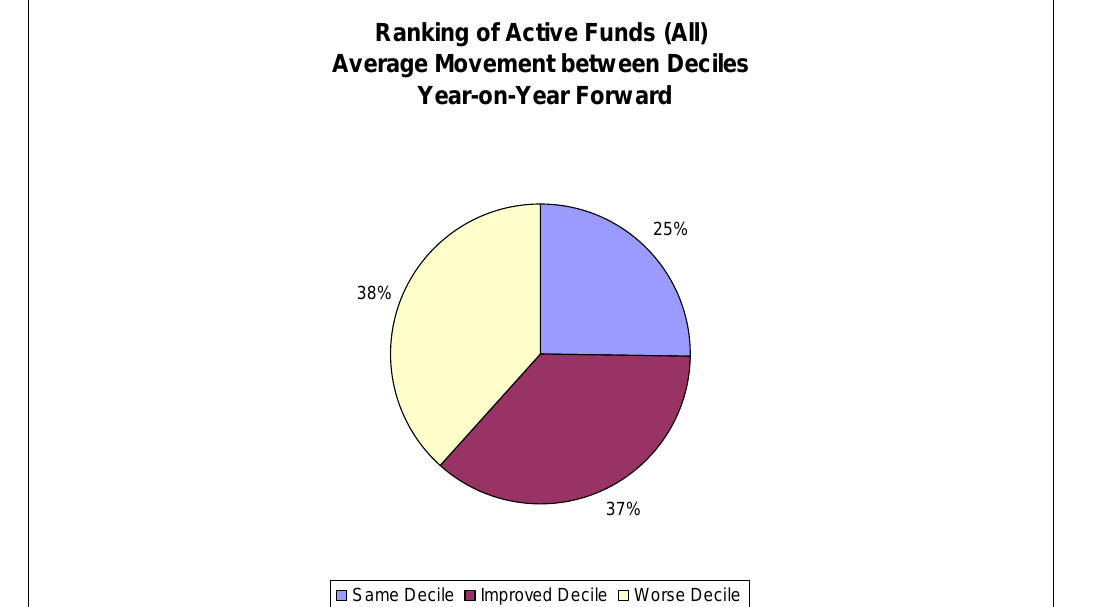
Figure 6: Tendency of actively managed funds to move between deciles on a yearly basis